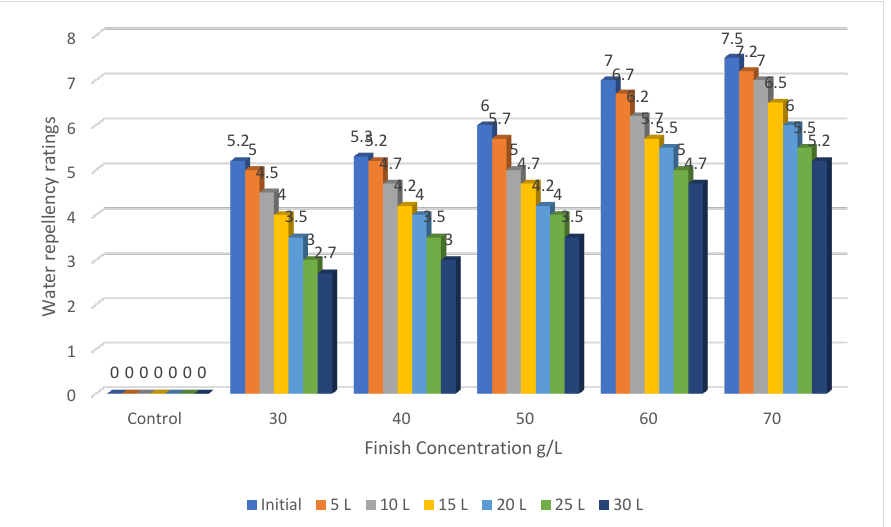
Table 1. Effect of laundering on Water-repellency (drop test) of polyester/cotton. Finish Conc.